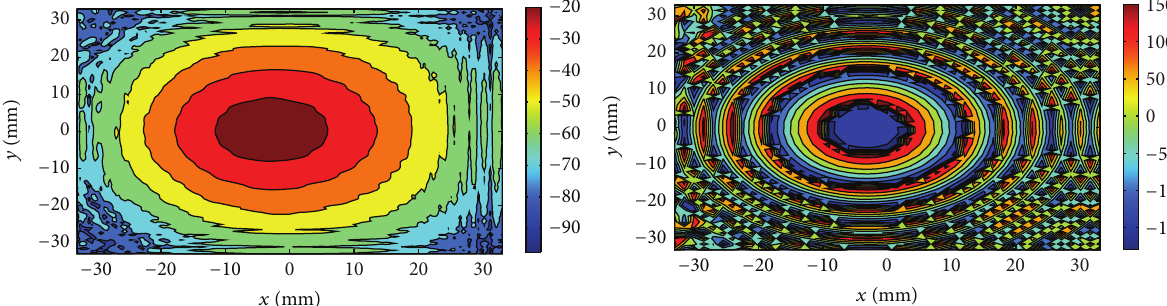
Figure 13: Measured near field amplitude and phase distributions of 325 GHz channel.